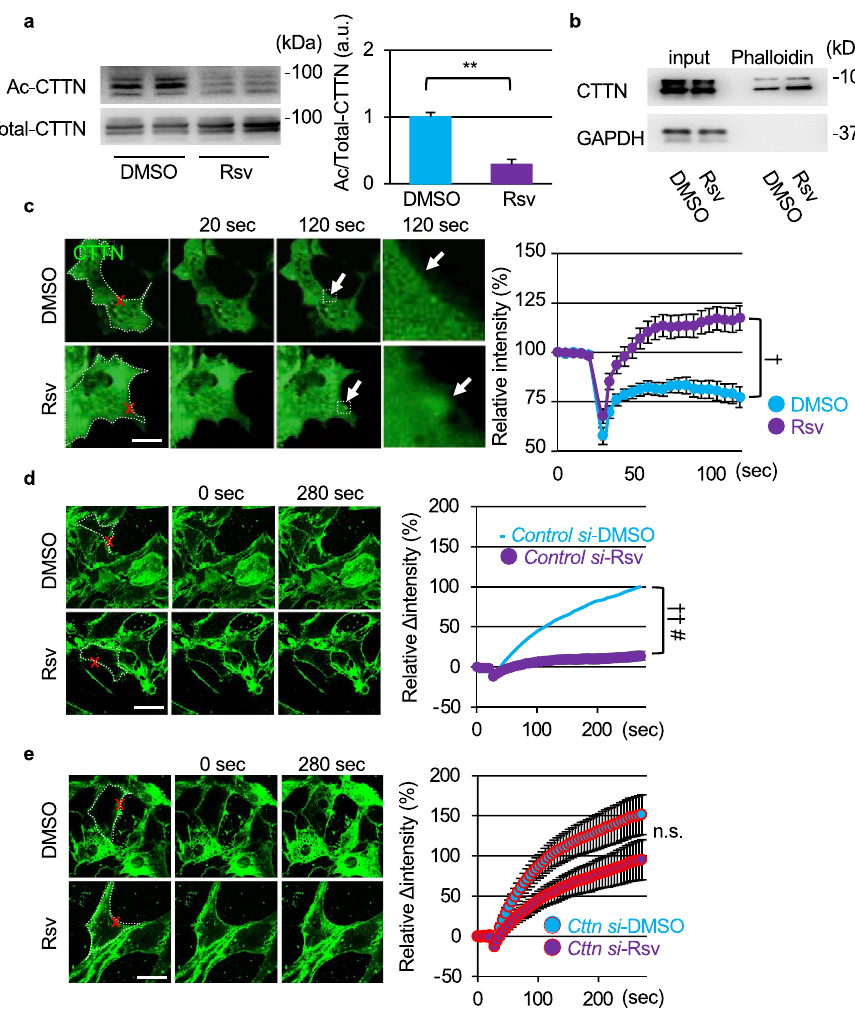
Figure 6. Resveratrol accelerates the accumulation of cortactin at the injured site via deacetylation of cortactin and promotes membrane resealing via cortactin. ( a ) Western blots of acetylated (top) and total (bottom) CTTN in C2C12 myoblasts 12 h after treatment with Rsv and quantification of acetylated CTTN normalize to total- CTTN (n = 3). ( b ) C2C12 myoblasts were treated with DMSO or Rsv and collected. Lysate and sediment pulled down with Biotin-XX-Phalloidin were assessed using anti-CTTN antibody. ( c ) COS7 cells were transfected with CTTN-mCherry. Representative images of CTTN-mCherry (green) immediately after and 100 s after laser injury. Arrows indicate injured sites. The right panel shows the intensity of CTTN-mCherry at the injured site (n = 11). ( d and e ) Left panels show representative images, and right panels show the time course of FM 1-43 dye influx before and after laser injury in DMSO- (top) and Rsv-(bottom) treated C2C12 myoblasts. C2C12 myoblasts were treated with Control (D, n = 12) or Cttn siRNA (E, n = 12) for 48 h before laser stimulation. Data are represented as means ± SD ( a ) or SEM ( c , d , and e ). A significant difference was determined by a two-tailed Student’s t -test: ** P < 0.01. † and †† indicate P < 0.05 and 0.01 at the last time point (120 s or 280 s), respectively. # indicates P < 0.05 based on the AUC value. n.s. = not